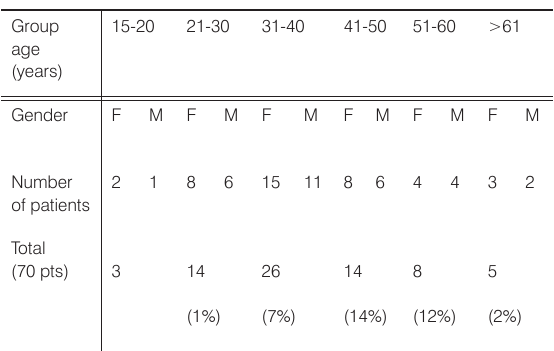
Table 2. Distribution of liver cysts with regard to age-group and sex in the second group